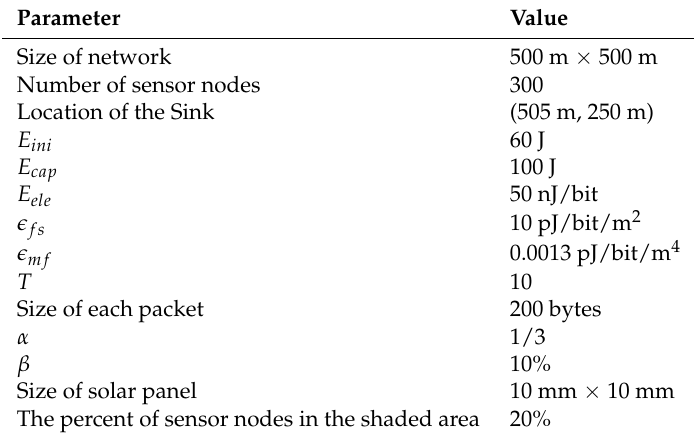
Table 1. Simulation parameter